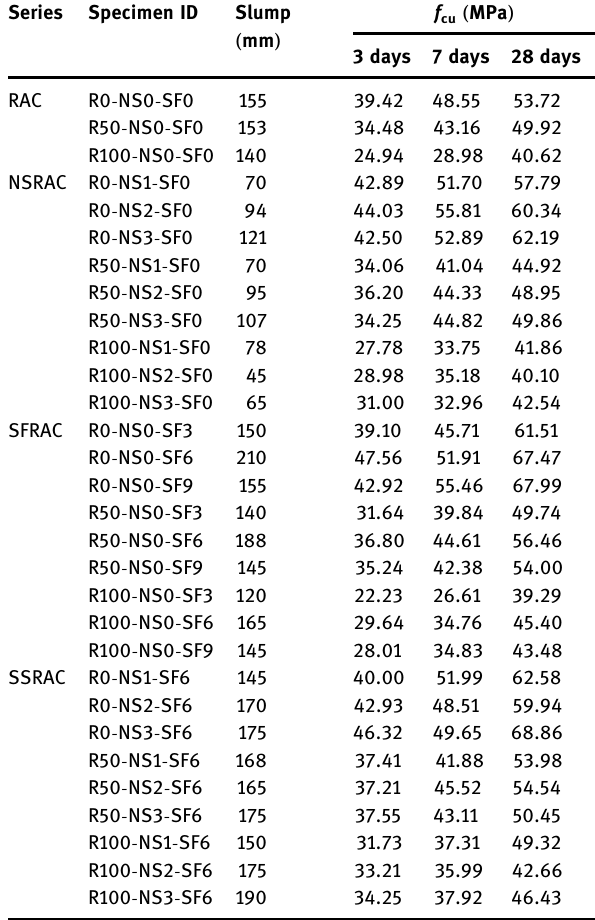
Table 6: Experimental results of cubic compressive